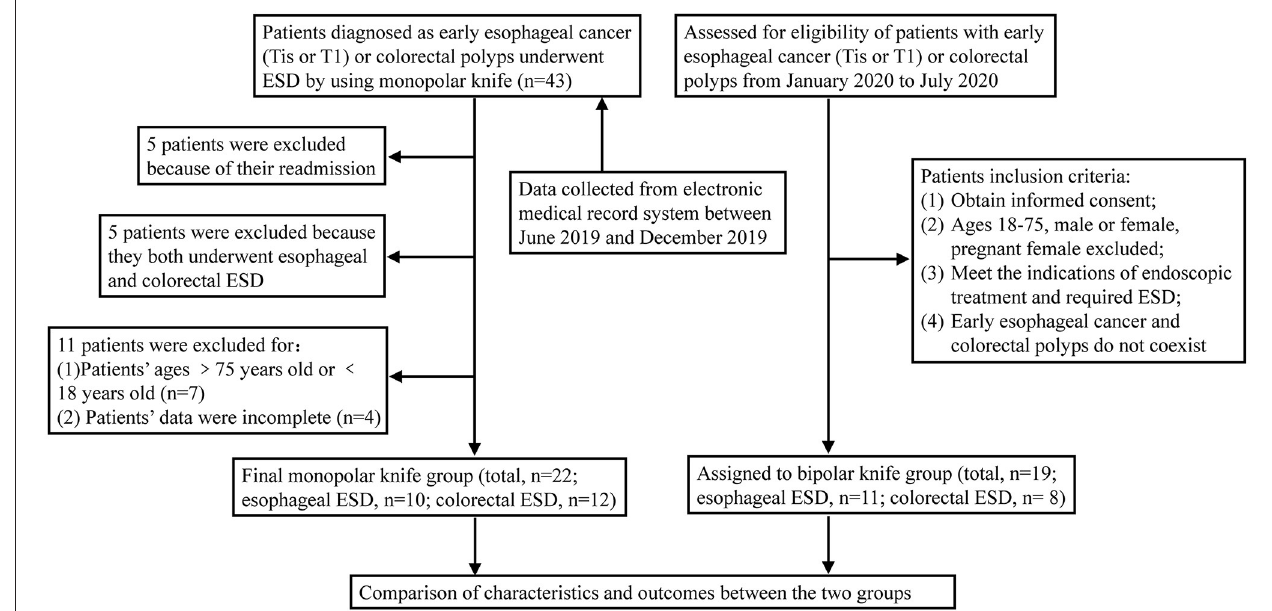
FIGURE 2 | Flow diagram depicting the patient selection process.